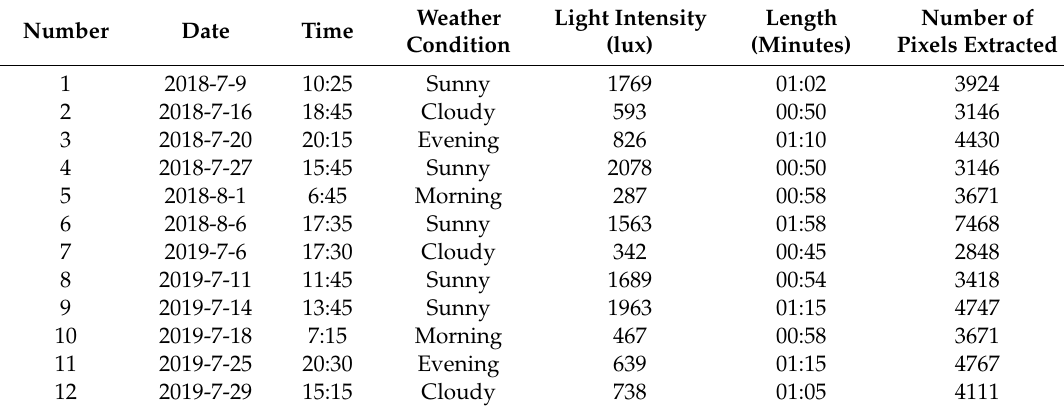
Figure 2. Different frames extracted from the recorded videos from different orchards. These frames correspond to the videos described in Table 1 with light intensities: ( a ) 826 lux; ( b ) 593 lux; ( c ) 342 lux; Table 1. Characteristics of the videos taken from the plum orchards under different conditions.